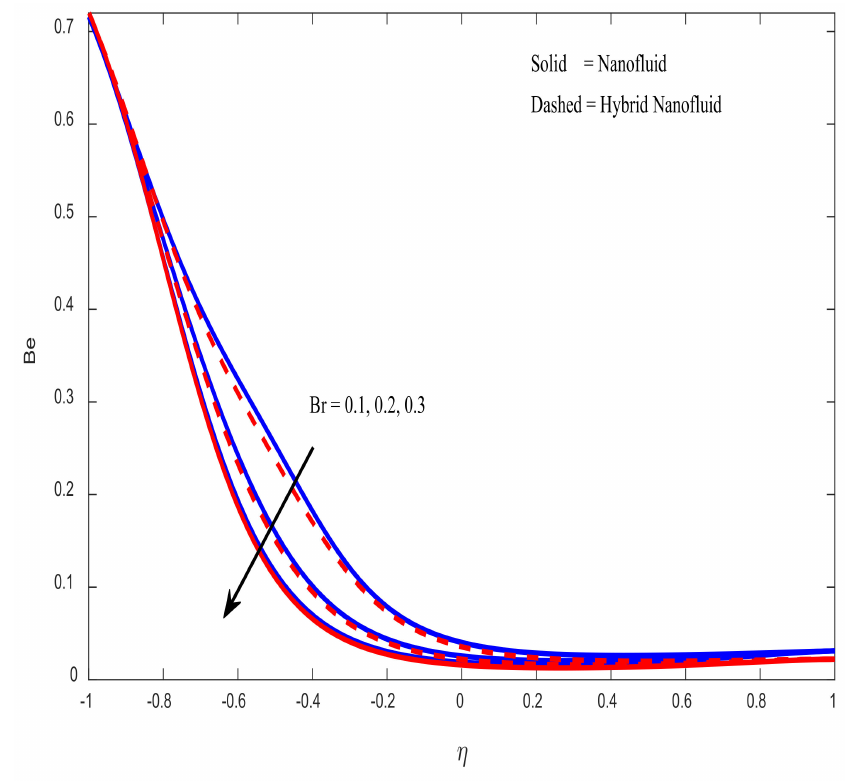
Figure 20. Influence Br on the Bejan number profile.